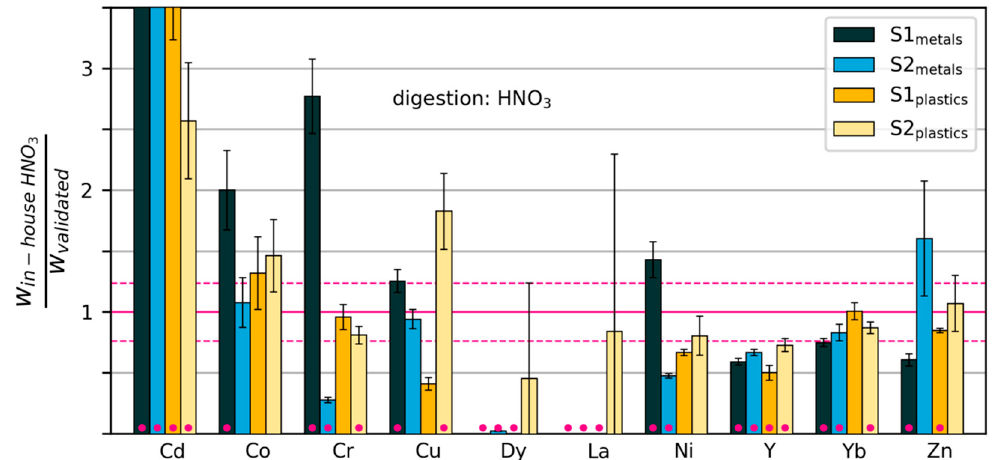
Figure 6. Mass fractions measured by “in-house” digestion in HNO 3 /H 2 O 2 , relative to mass fractions measured with the validated method. The dashed horizontal lines show the relative standard deviation of the validated measurements across all elements. Error bars extend one standard deviation above and below the mean (calculated from three repeated digestions/measurements). Pink dots indicate that the measurements were significantly different from those of the validated method ( p < 0.02). Some values are too large to be displayed within the limits of the y -axis (see Table S1).